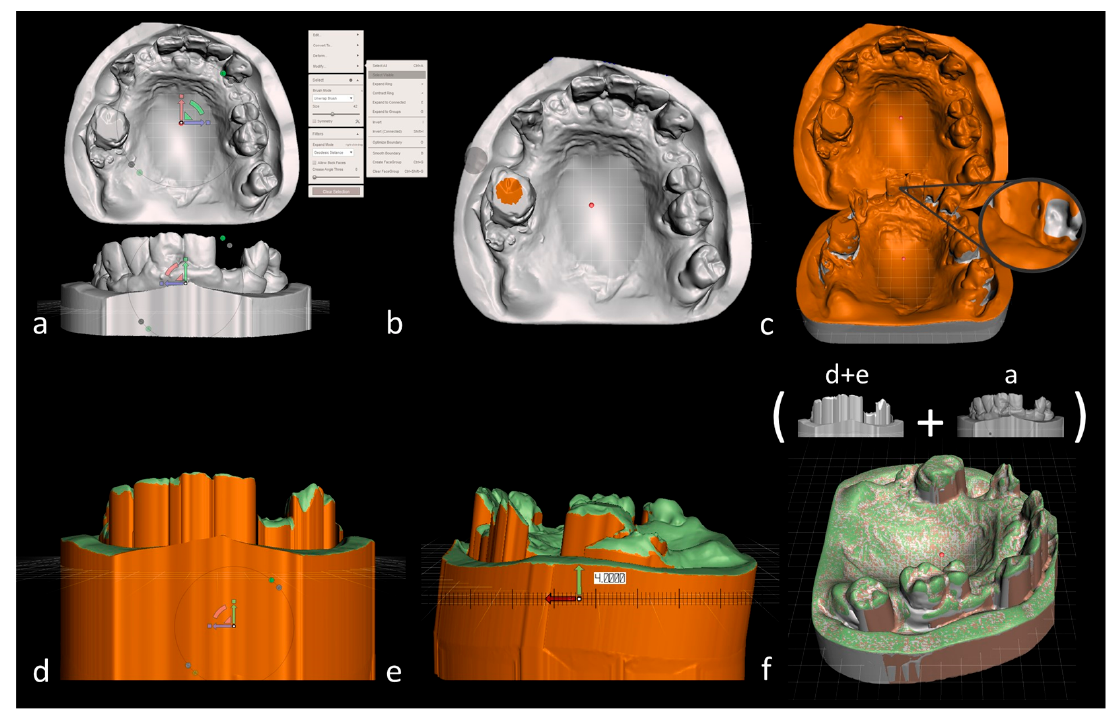
Figure 4. Workflow used to identify the undercuts and blocking out the maxillary digital cast. ( a ) Digital maxillary cast with its center aligned in the world origin of the 3D modeling software. Note the Y-axis perpendicular to the occlusal plane, anteroposterior X-axis, and mediolateral Z-axis. ( b ) Determination of the path of insertion and undercuts using the operator’s view of the digital cast as reference using the “select visible “function. ( c ) Undercuts requiring blockout (grey). Note the careful inspection of the cast to select small pinpoint areas to prevent problems with the blockout procedure. ( d ) First blockout (vertical) performed by displacing the undercut areas in the -Y direction (orange) using the transform tool. ( e ) Second blockout performed in a duplicate of the digital cast. Note displacement in the X+ direction to eliminate large anterior soft tissue undercuts. ( f ) Merging of first and second blocked-out casts ( d + e ) with digital maxillary cast ( a ). At this stage, the internal irregularities of both blocked-out models were filled with the “make solid” function in the modeling software before combining them with the original maxillary digital cast to create the final blocked-out maxillary digital cast.